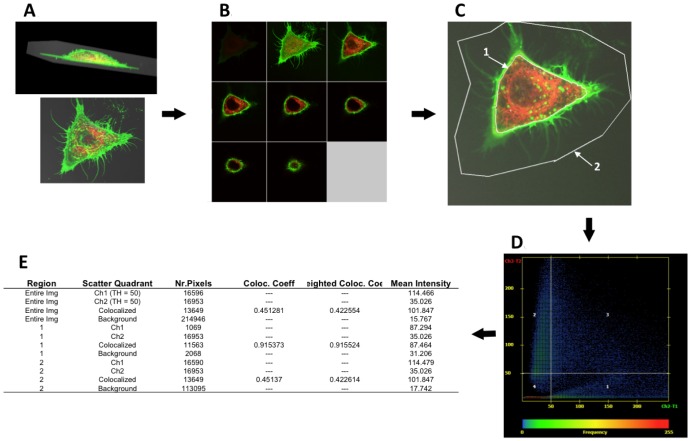
Demonstration of methods for quantifying confocal imaging data.A. Cells were imaged as 1 µm vertical stacks at different times following the administration of ricin (always green in all figures). The cells were genetically modified to express DsRed in the endoplasmic reticulum. B. Each plane was viewed separately in this display. C. The third vertical image (upper right in panel B) was chosen for analysis. Two ROI’s were drawn: ROI 1. contains the intracellular ricin, ROI 2. defines the total amount of ricin associated with the cell. D. and E. are graphical and mathematical representations of the visual data.